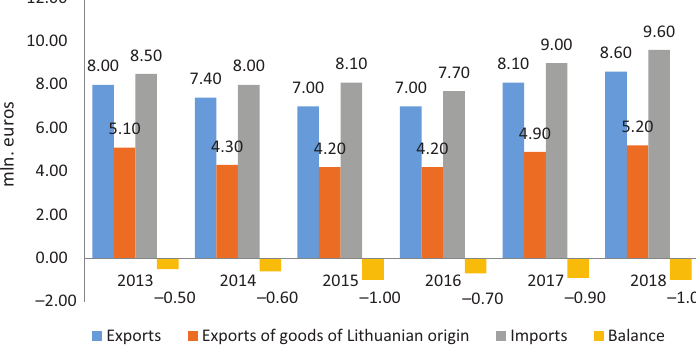
Figure 1. Lithuanian exports and imports during 2013–2018 (source: LB, 2019a)